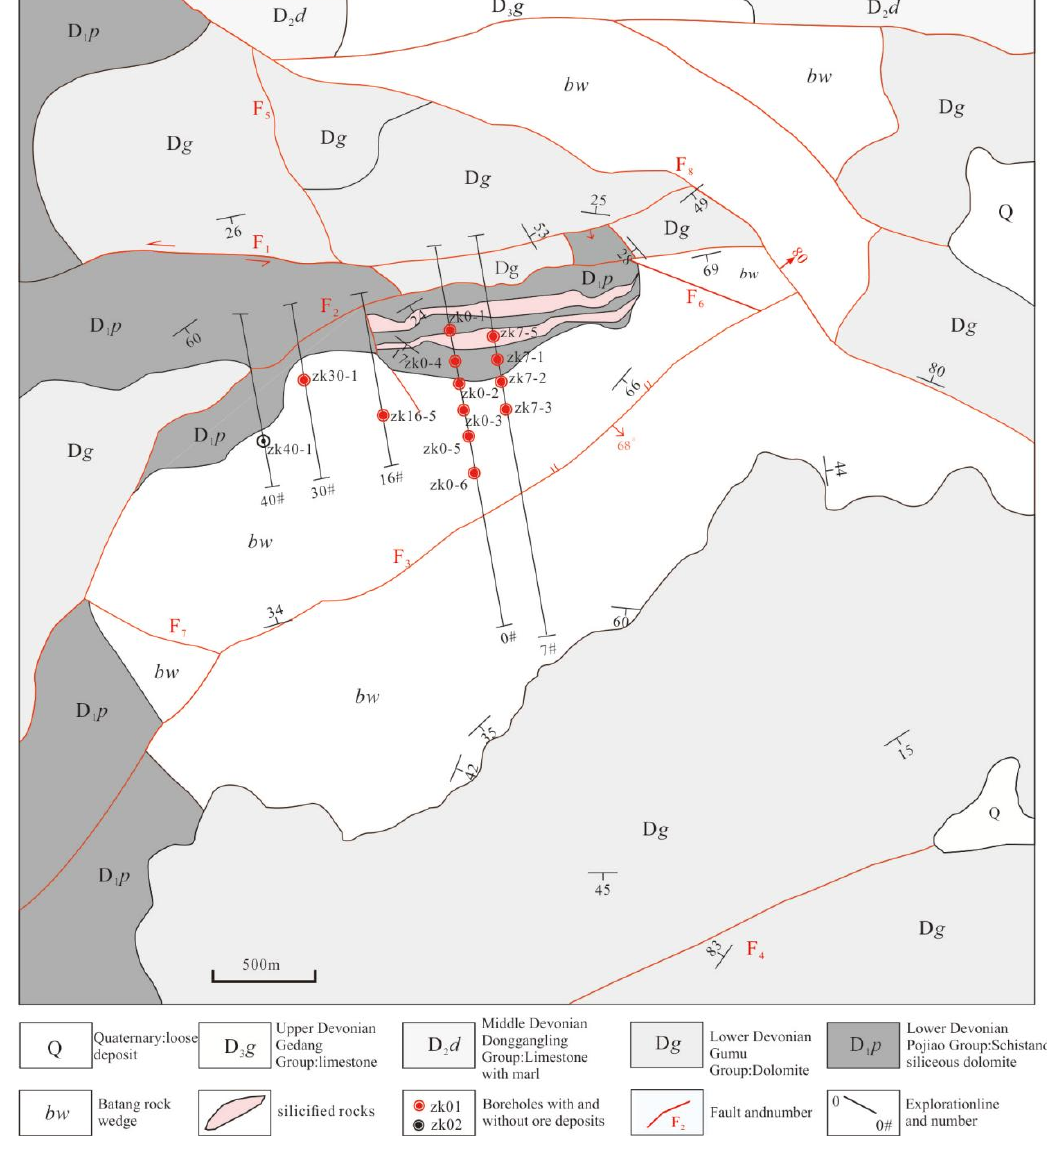
Figure 2. Geological map of mining